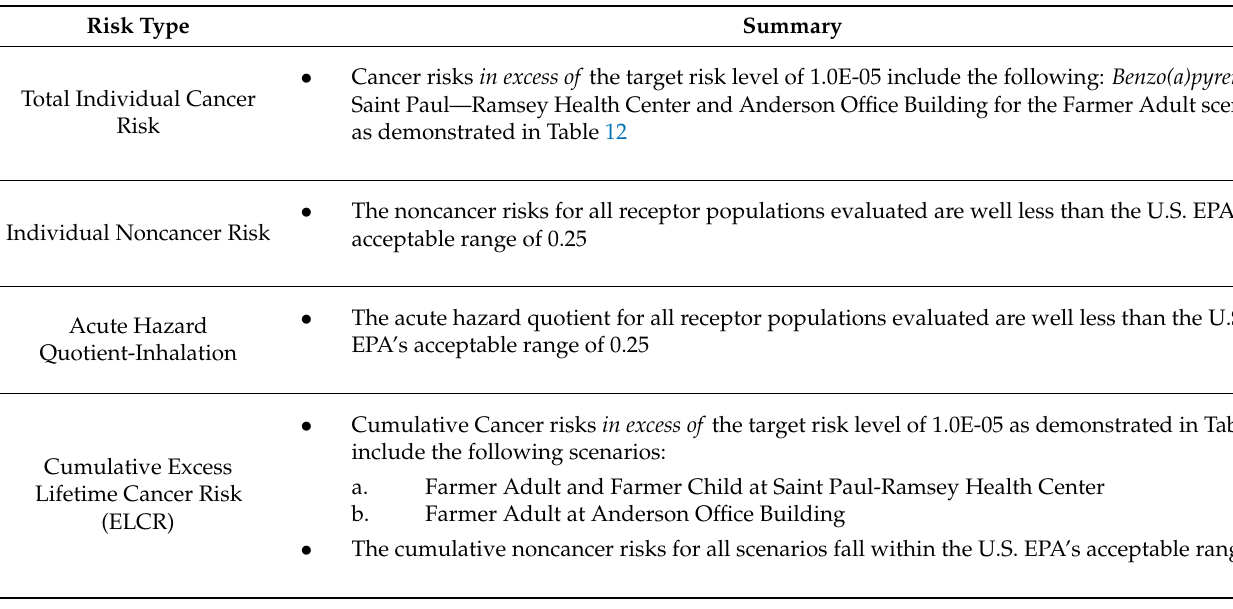
Table 15. Summary of the Comprehensive Multi-pathway Human Health Risk